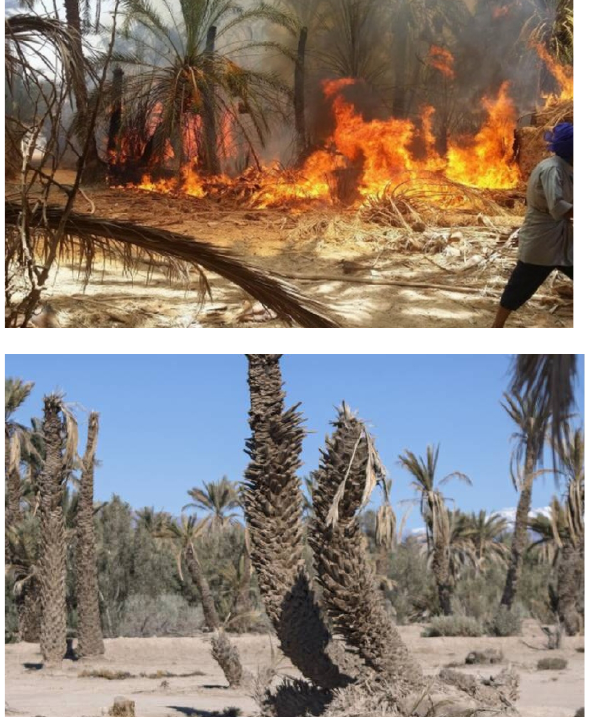
Figure 2 . Short hard winters and long hot summers lead frequent to fires [top, (Panafricaines, 2020)] and deadly illnesses of the palm trees [bottom, (Geo, 2020)].